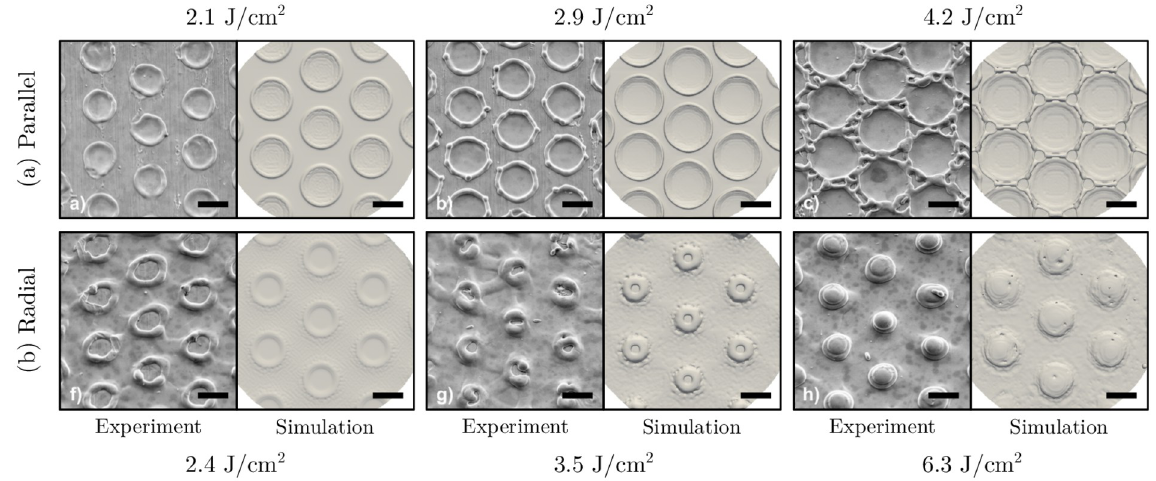
Fig 6. Experimentally measured and numerically simulated three-dimensional surface structures for (a) the parallel polarization orientation, and (b) for the radial polarization orientation for different laser fluences. Experimental data from Voisiat et al. [25]. The black scale bar corresponds to 5 µ